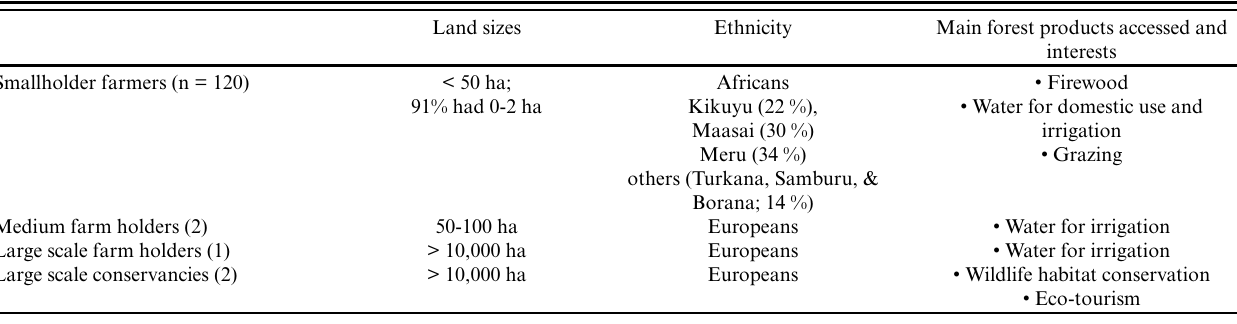
Table 1 . Selected socioeconomic characteristics of respondents and their access to various forest products (Source: Survey data and focus group